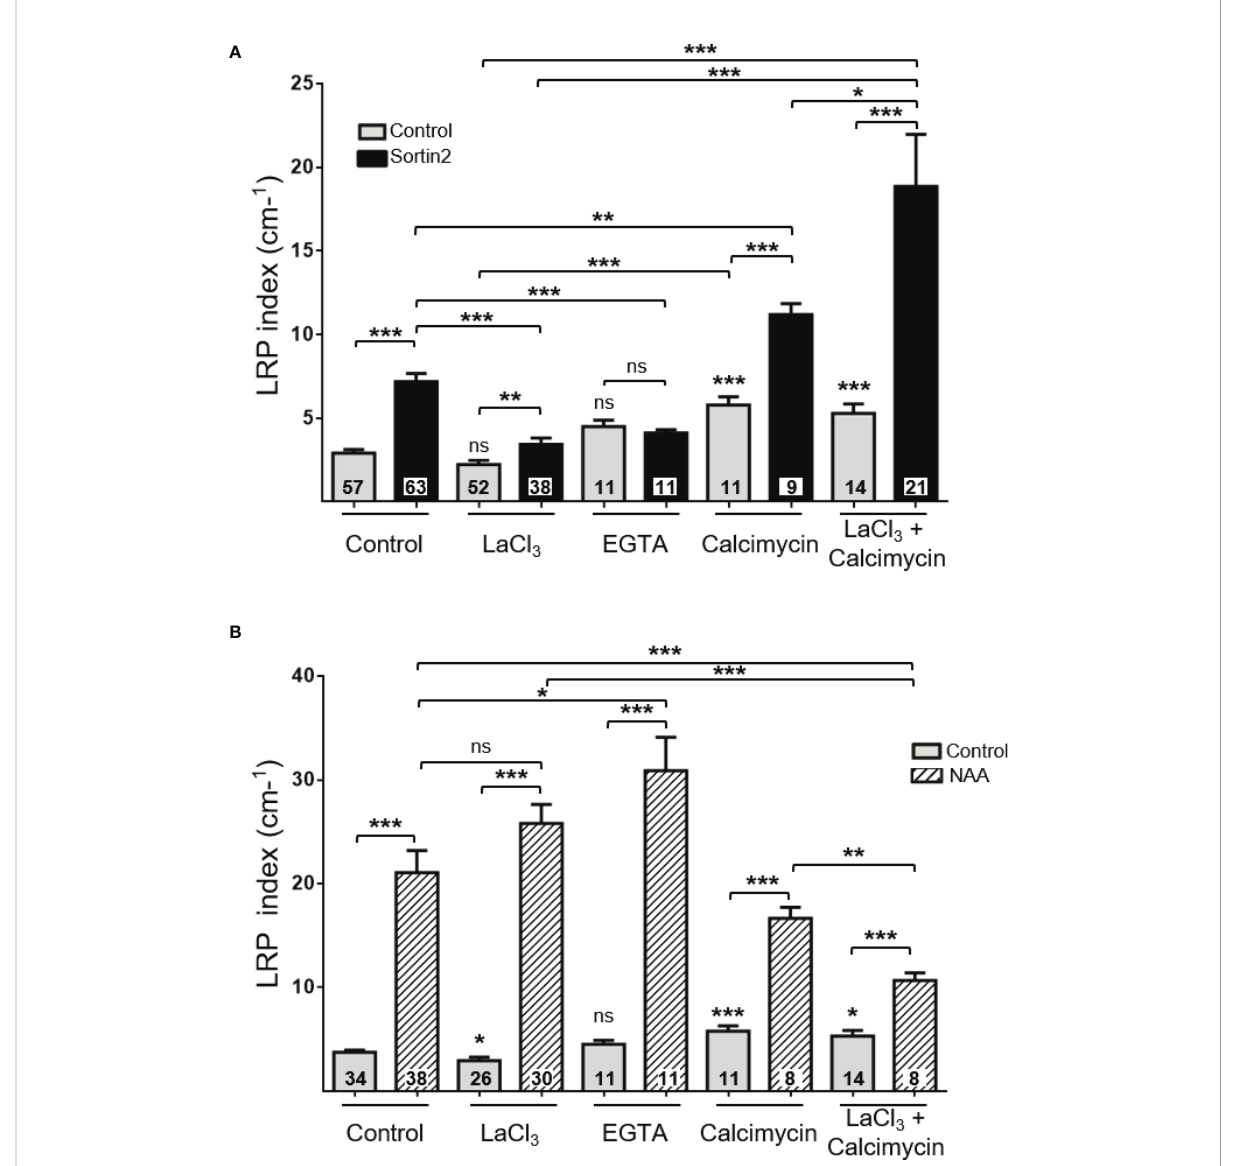
FIGURE 5 The requirement for extracellular calcium uptake reveals a distinctive lateral root initiation mechanism induced by endocytic traf fi cking from auxin NAA induction. Induction of lateral root primordia by Sortin2 (A) and NAA (1 m M; B ) in the presence of LaCl 3 (1 mM), EGTA (10 mM), the ionophore calcimycin (80 µM) or calcimycin plus LaCl 3 (1 mM) for 72 hours in 7-day-old Col-0 seedlings. Numbers inside bars indicate the number of seedlings scored in three independent experiments. One-way ANOVA and Tukey ’ s post-hoc test were performed. Statistically signi fi cant differences between the control condition and a speci fi c treatment are indicated above each bar. Brackets denote statistical differences between conditions (* p < 0.05; ** p < 0.01; *** p < 0.001; ns, not signi fi